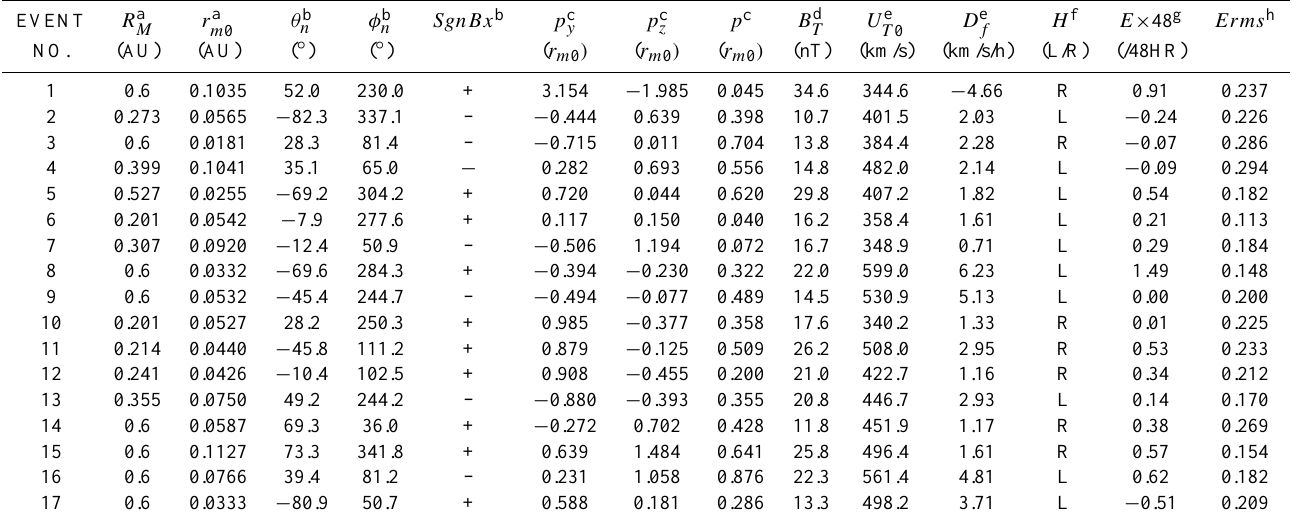
Table 2. Magnetic cloud parameters determined by the fitting to the torus flux rope